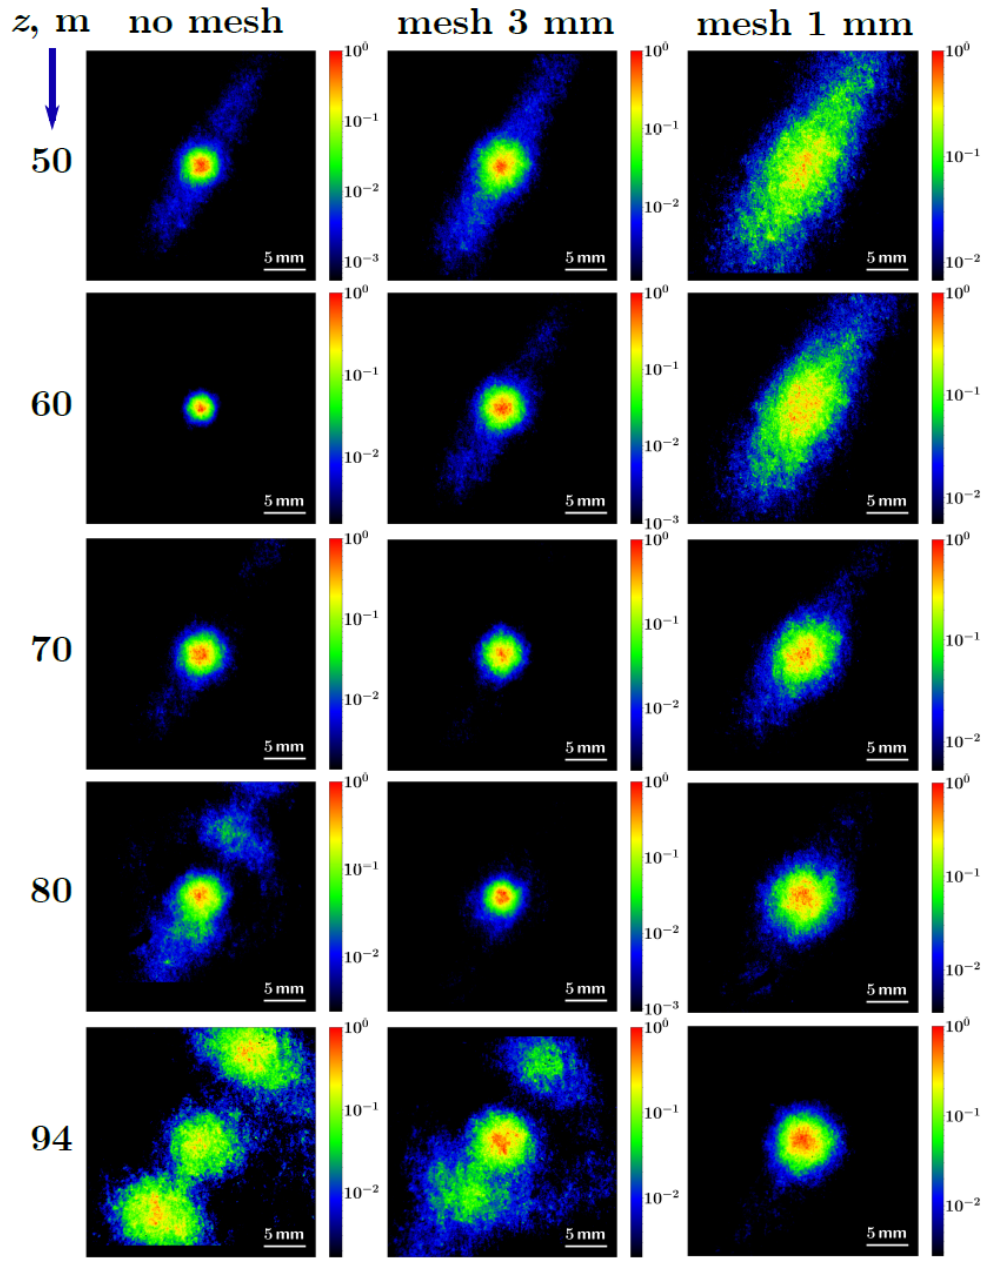
Figure 2. Normalized transverse fluence distributions measured at different distances z in the range from 50 m to 94 m for the free propagation without a mesh (left column) as well as in the case of regularization by the mesh with 3 mm cells (middle column) and 1 mm cells (right